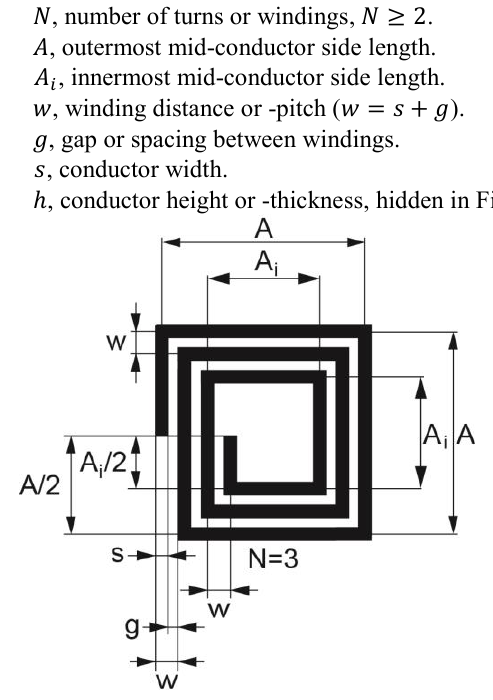
Figure 1: The layout of a square planar spiral coil and its de- sign